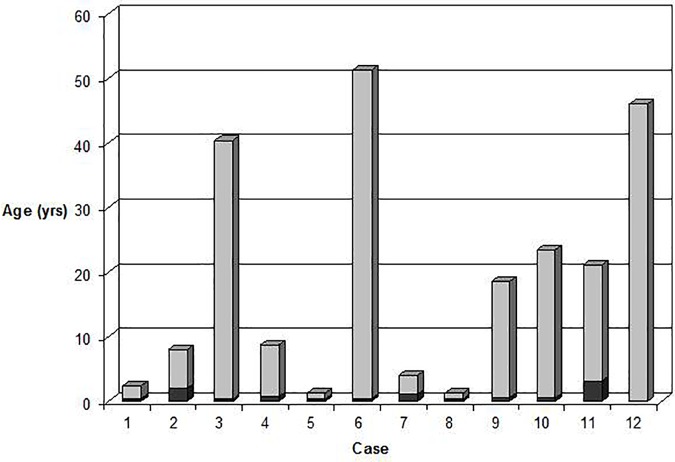
Age at onset of anemia (dark gray) compared with age at diagnosis (light gray) in the 12 GPI deficient patients.